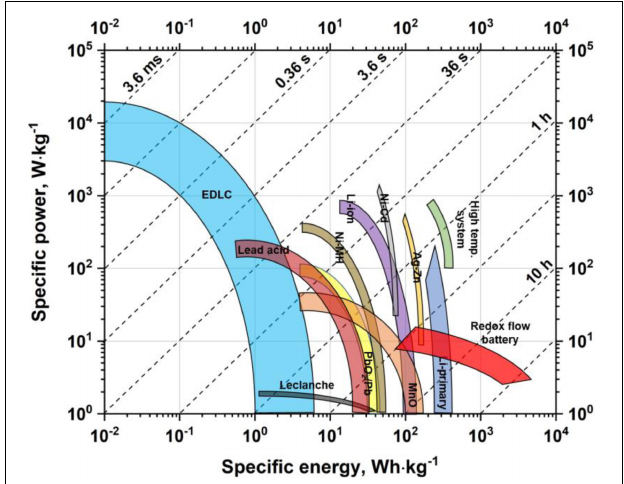
FIGURE 1 | The Ragone plot presenting specific power and energy values reached by different energy storage devices. Based on data sourced from Simon and Gogotsi (2010), Béguin and Fra¸ckowiak (2013), Budde-Meiwes et al. (2013).